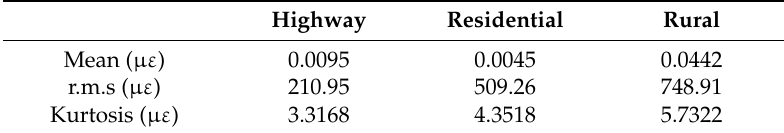
Table 5. Statistical analysis of strain